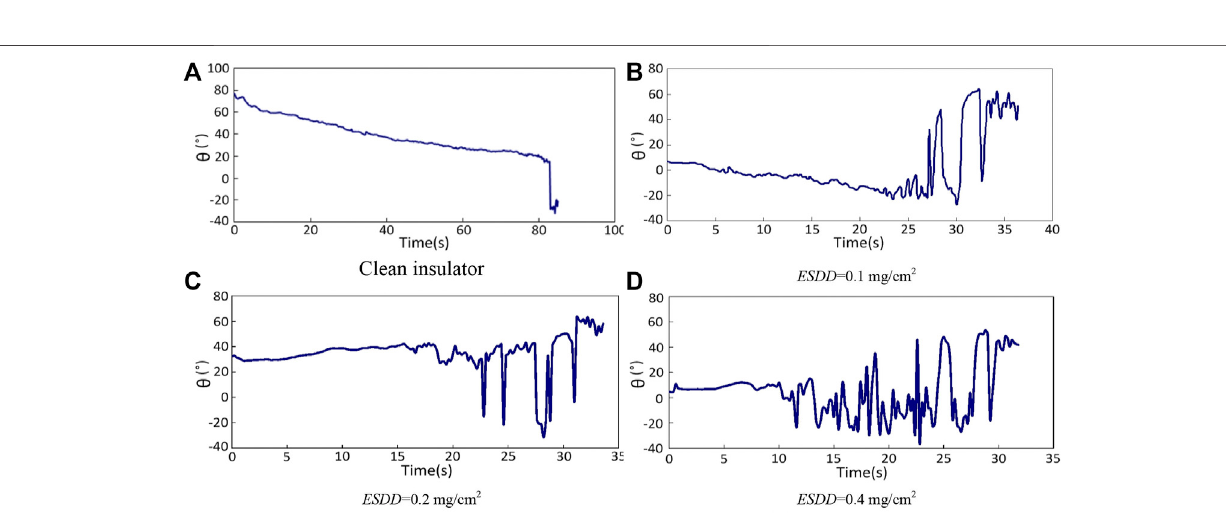
Frontiers in Energy Research |